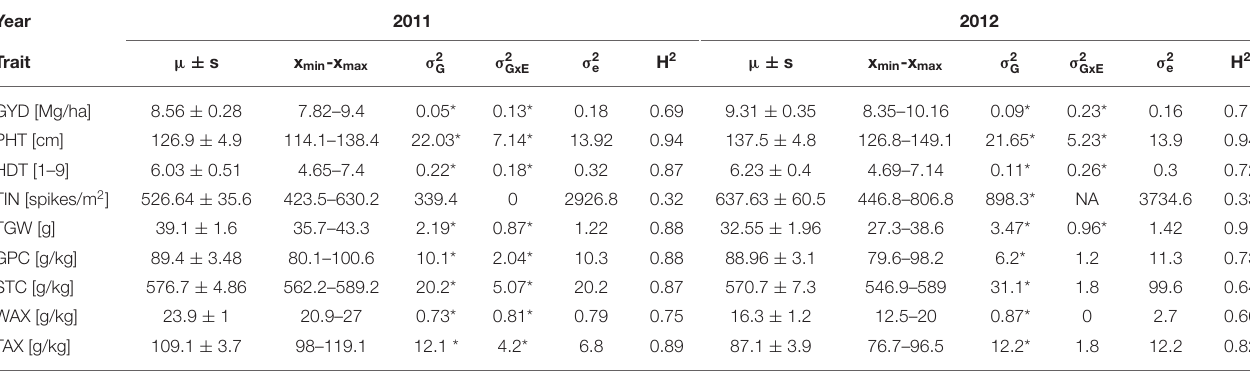
TABLE 1 | First and second order statistics of experimental rye hybrids. Year 2011 2012 Trait µ ± s x min -x